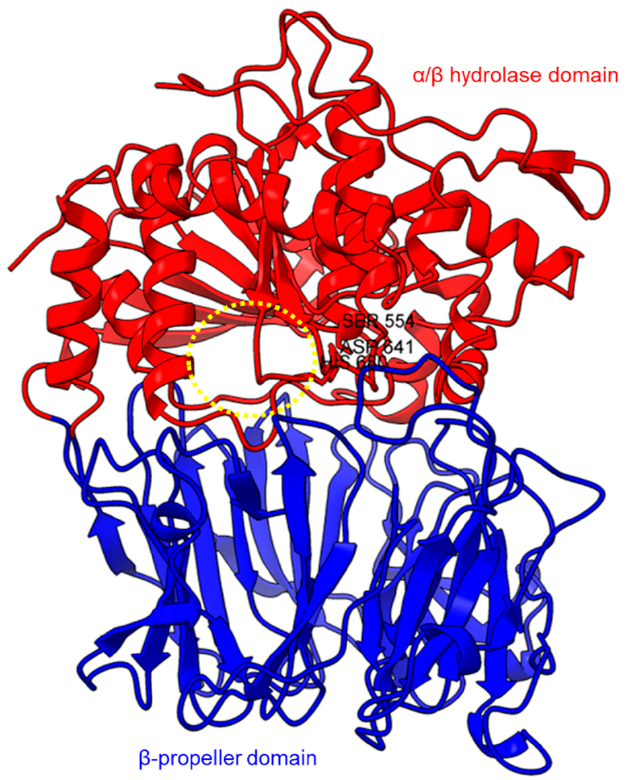
Figure 1. Crystal structure of a porcine POP (PDB ID: 1QFM). In red is the α / β hydrolase catalytic domain, whereas the β -propeller domain is highlighted in blue. Catalytic triad residues: Ser554, Asp641, and His680 are labeled. The yellow circle indicates a probable accessible path discovered in an electron microscopy study [75].